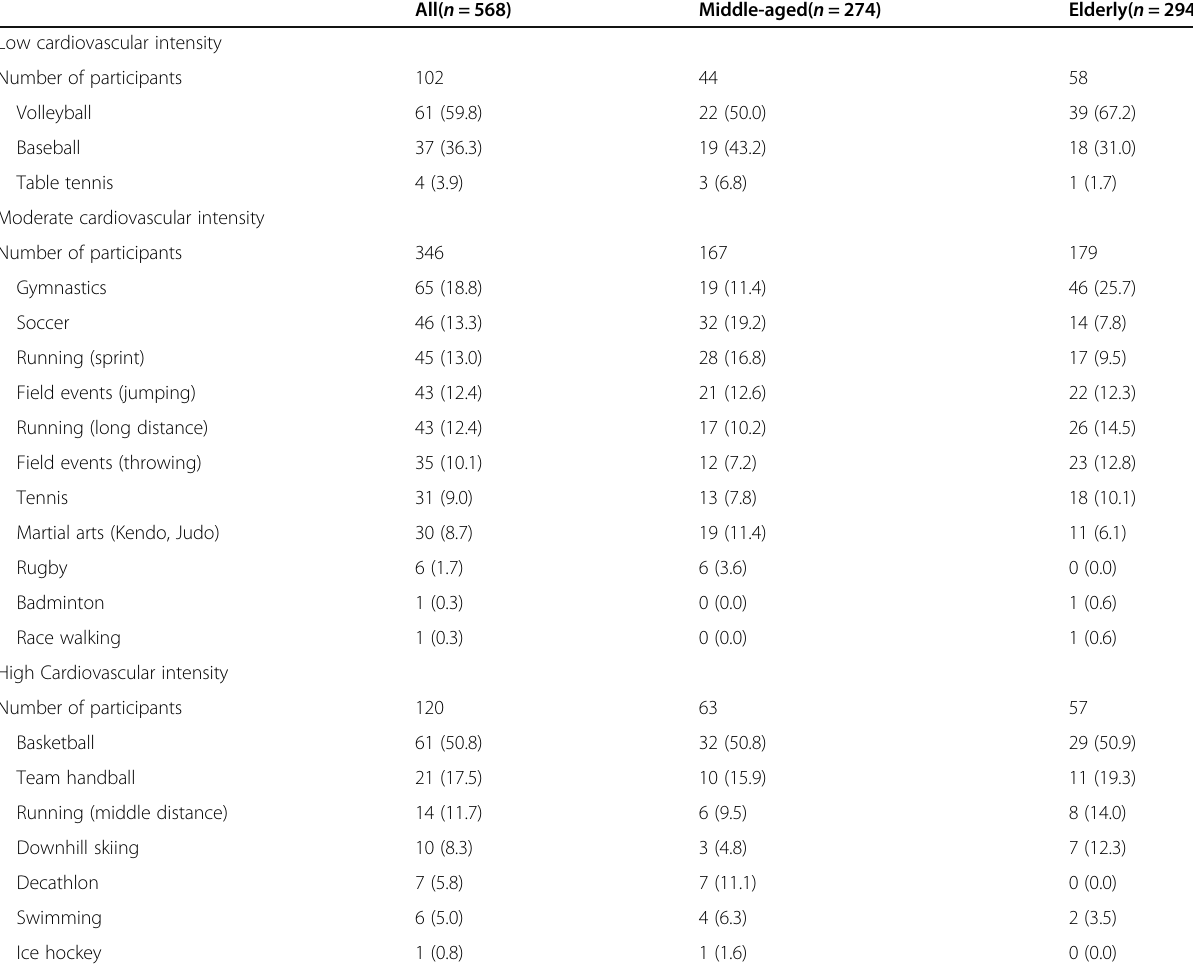
Table 2 College sports club disciplines, stratified by three levels of cardiovascular intensity (low, moderate, and high) All( n =